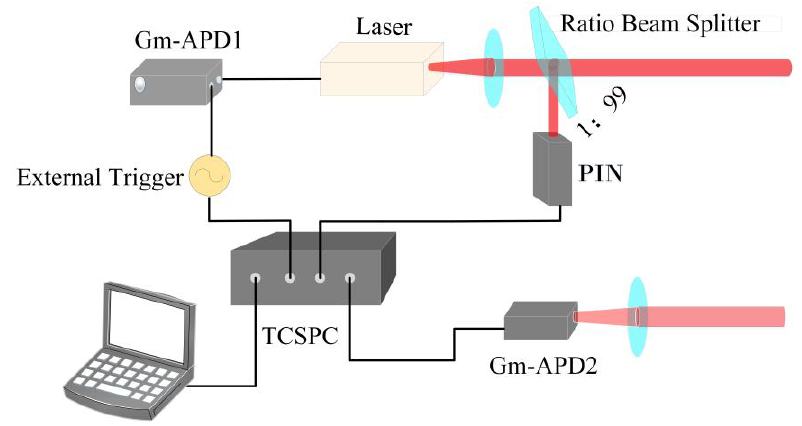
Figure 3. Schematic of the true random coding photon counting LIDAR system.